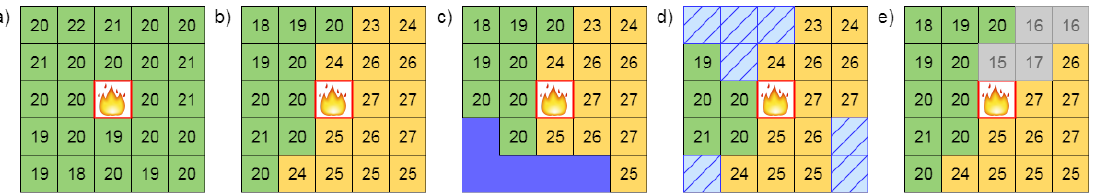
Figure 1. Examples of contextual temperature determination scenarios—( a ) uniform contextual surroundings, with low spatial variance; ( b ) land cover change (yellow/green), with pixels of multiple land cover classes contributing to the estimate; ( c ) waterbodies (dark blue), which permanently obscure part of the contextual kernel; ( d ) cloud obscuration (hatched blue), which intermittently causes missing contextual data; and ( e ) smoke (grey), which provides directional partial obscuration of downwind pixels, and is less likely to be masked out of images than